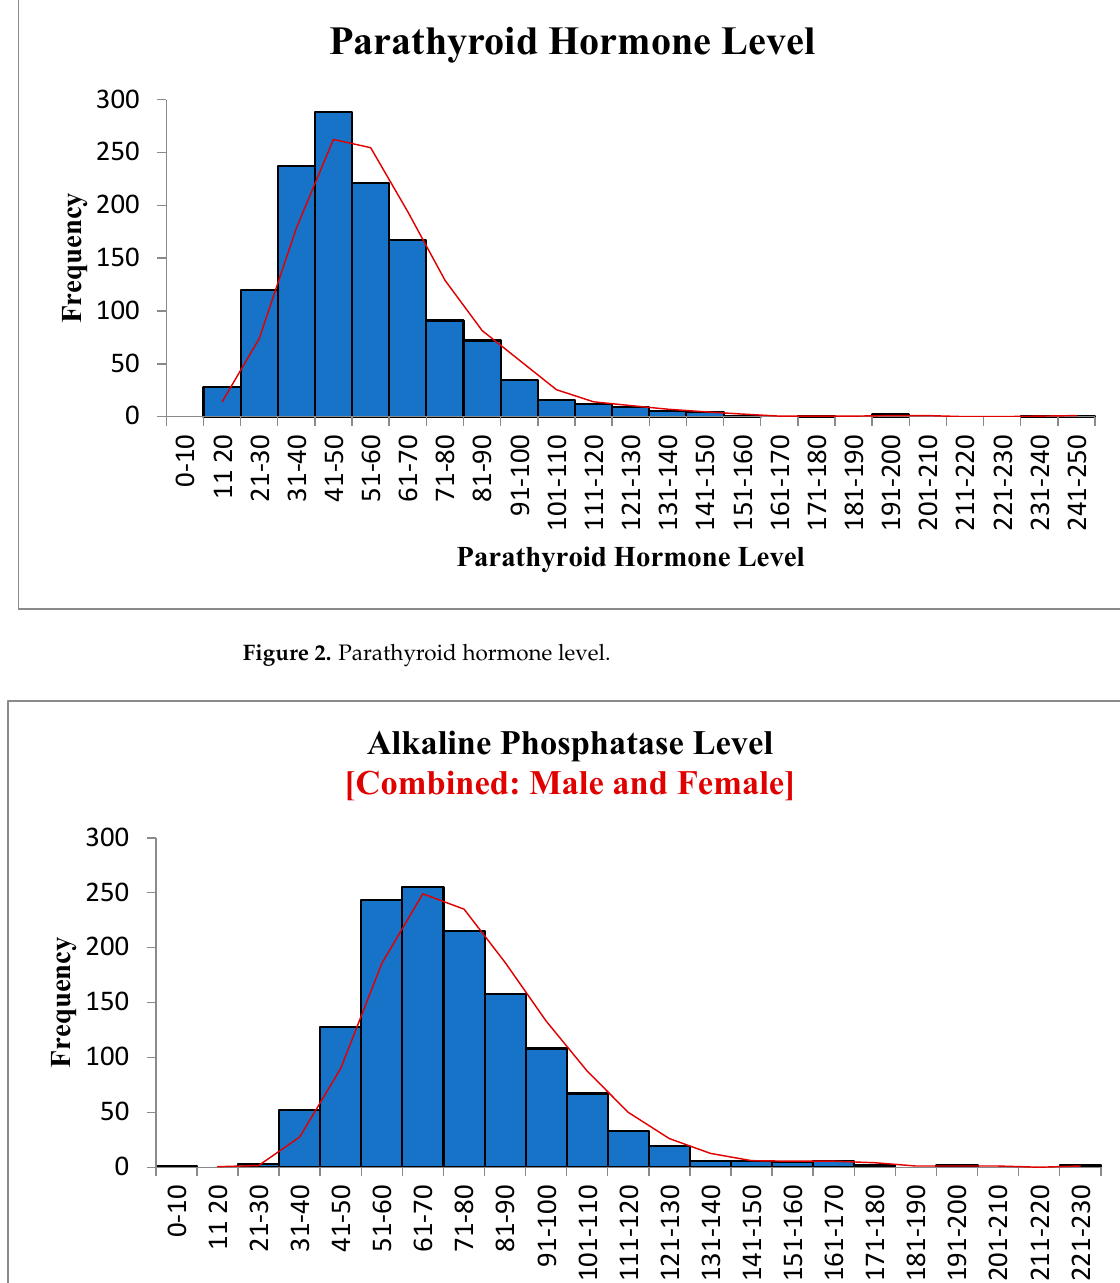
Figure 1. Vitamin D level.